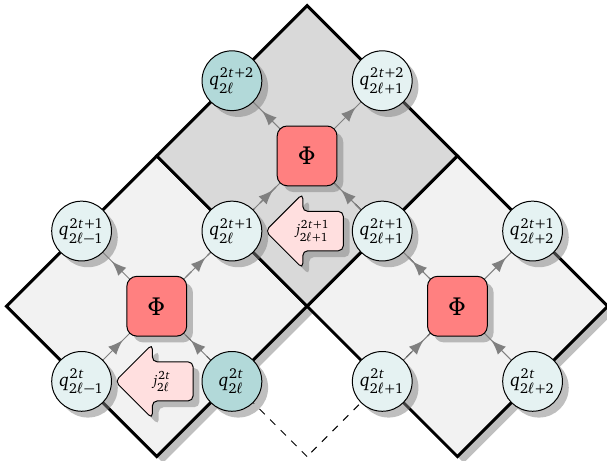
Figure 3: Discrete Noether current, shown at an even site 2 (cid:96) : the time-increment (cid:0) (cid:1) /τ − q t t → t + 2 of charge density, q t + 2 equals the difference of two nearby cur- 2 (cid:96) 2 (cid:96) − j 2 t rent densities at consecutive times, j 2 t + 1 . Current densities j t 2 (cid:96) 2 (cid:96) + 1 arrows, can be compactly expressed as the difference of charge densities at consecu- = ( q t + 1 − q t ) /τ tive times, j t (cid:96) (cid:96) (cid:96)